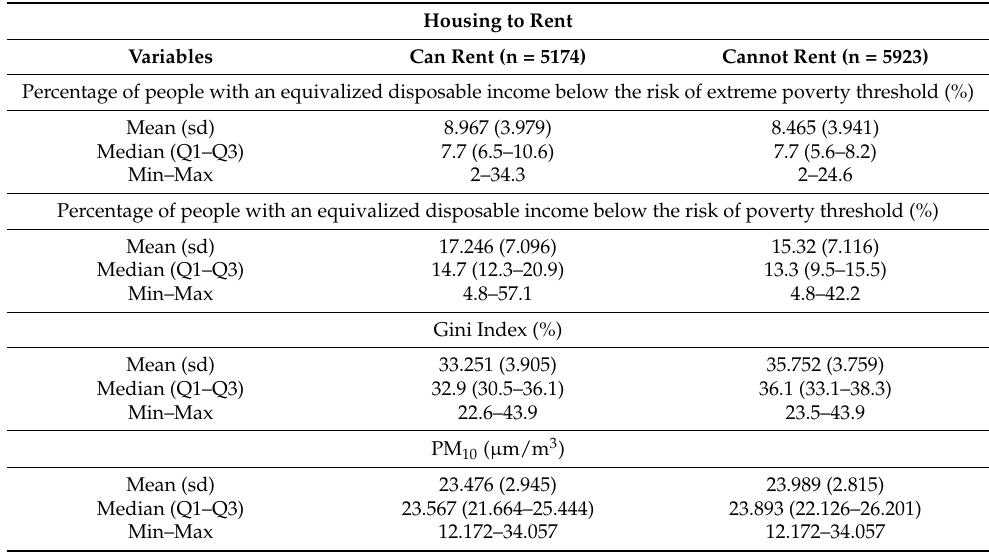
Table 1. Bivariate analysis according to the possibility of